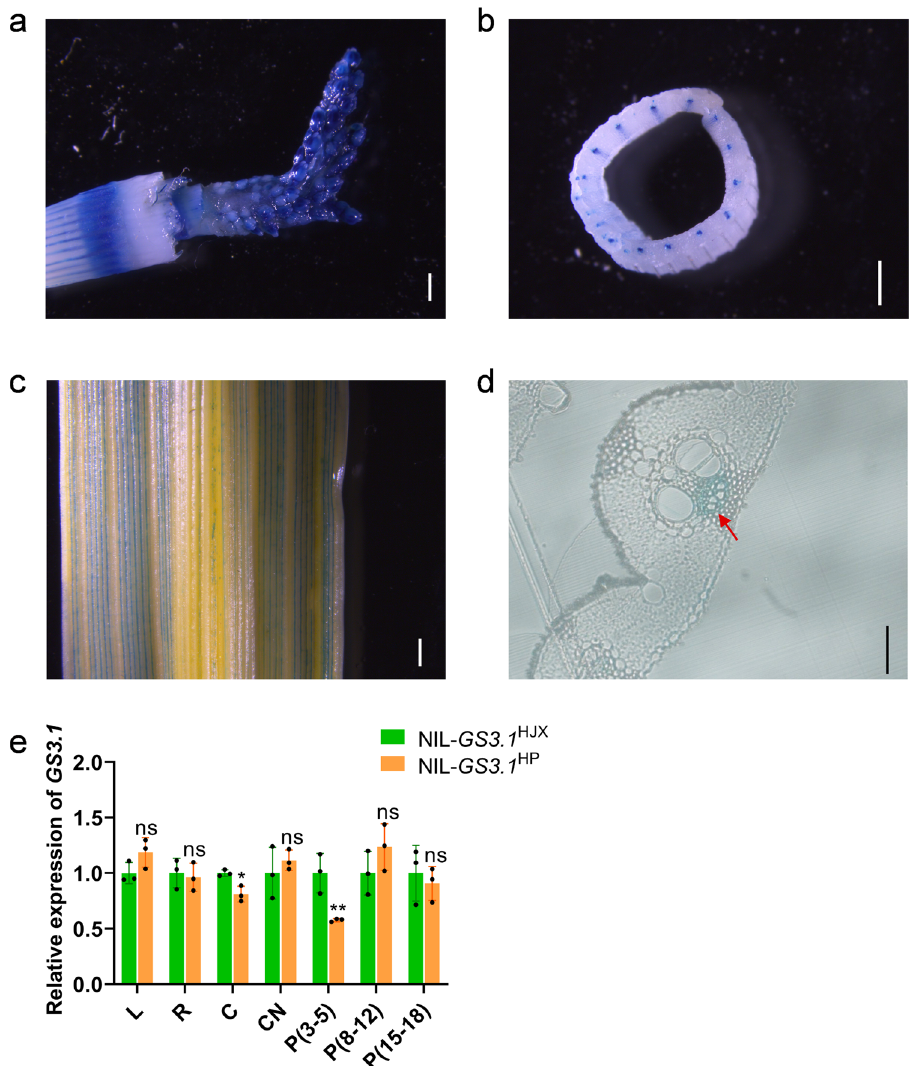
Fig. 3 GS3.1 expresses in young panicles and the phloem of leaves and culms. GUS staining of Pro GS3.1 HJX :GUS of a young 1 cm-long panicle ( a ), culm ( b ), and leaf ( c ). Scale bar = 1 mm. d Micrograph of a cross-section of a young leaf. The red arrow shows the stained phloem. Scale bar = 50 μ m. e The relative expression levels of GS3.1 in NIL- GS3.1 HJX and NIL- GS3.1 HP leaves (L), roots (R), culm nodes (CN), culms (C), and panicles (P, numbers indicate the length of young panicles, cm) as determined by qRT-PCR ( n = 3 biological replicates). The actin gene was used for normalization. The values in e represent the mean ± s.d.. * P < 0.05 and ** P < 0.01 indicate signi fi cant differences compared to NIL- GS3.1 HJX in two-tailed Student ’ s t -tests. The source data underlying Fig. 3e are provided as Source data fi